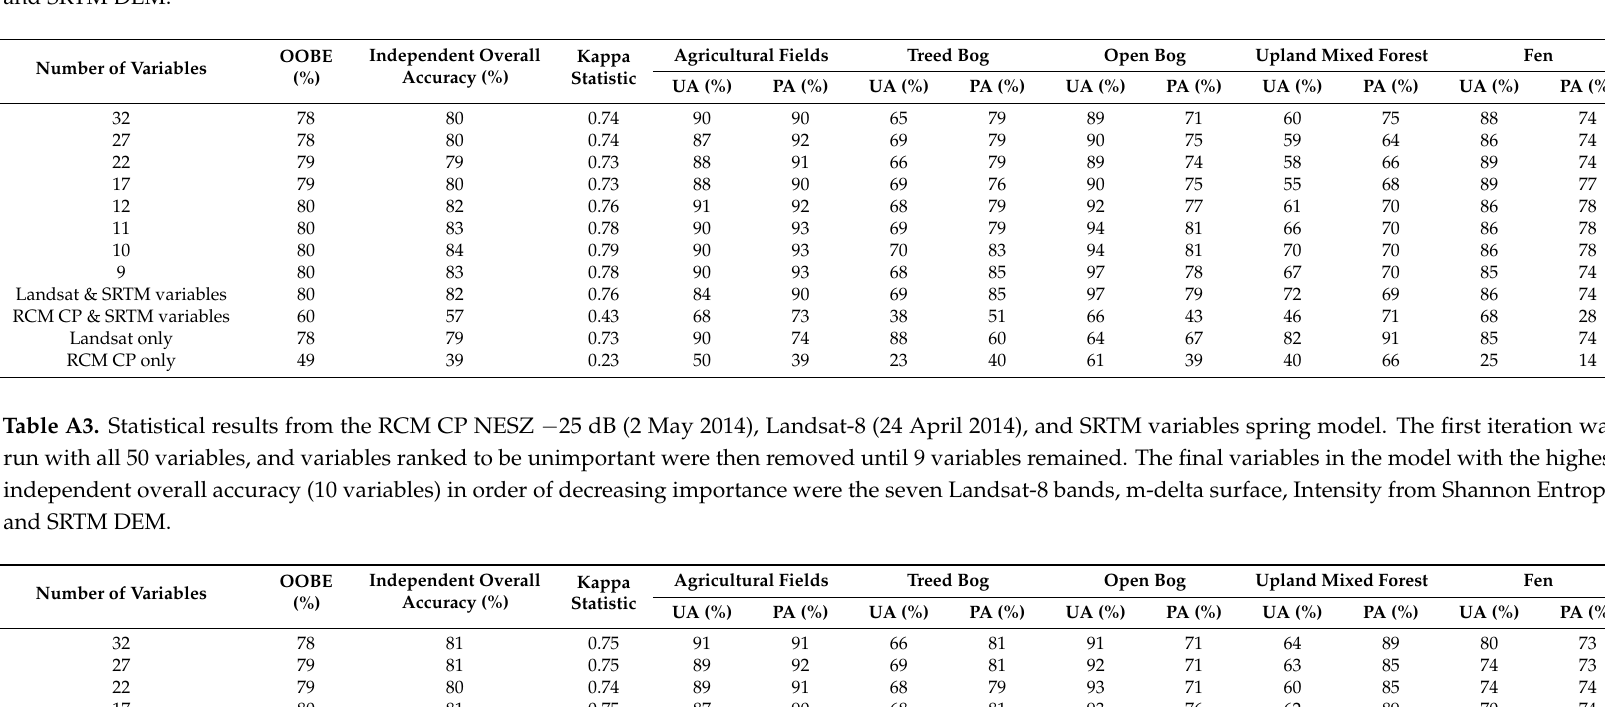
Table A2. Statistical results from the RCM CP NESZ − 19 dB (2 May 2014), Landsat-8 (24 April 2014), and SRTM variables spring model. The first iteration was run with all 50 variables, and variables ranked to be unimportant were then removed until 9 variables remained. The final variables in the model with the highest independent overall accuracy (10 variables) in order of decreasing importance were the seven Landsat-8 bands, m-delta surface, Intensity from Shannon Entropy, and SRTM DEM.